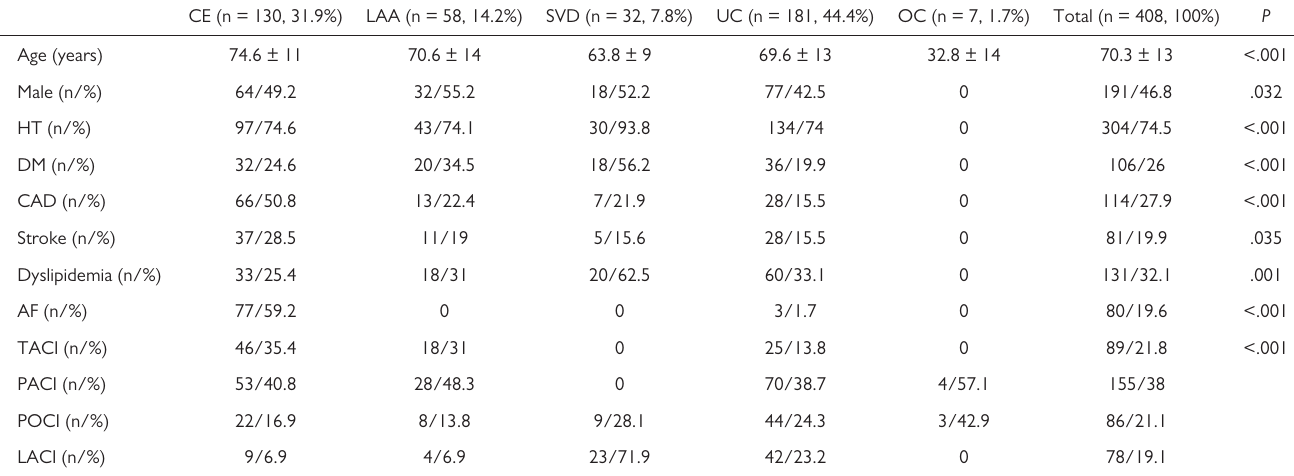
Table 3. Demographic Findings of Ischemic Strokes according to Etiology